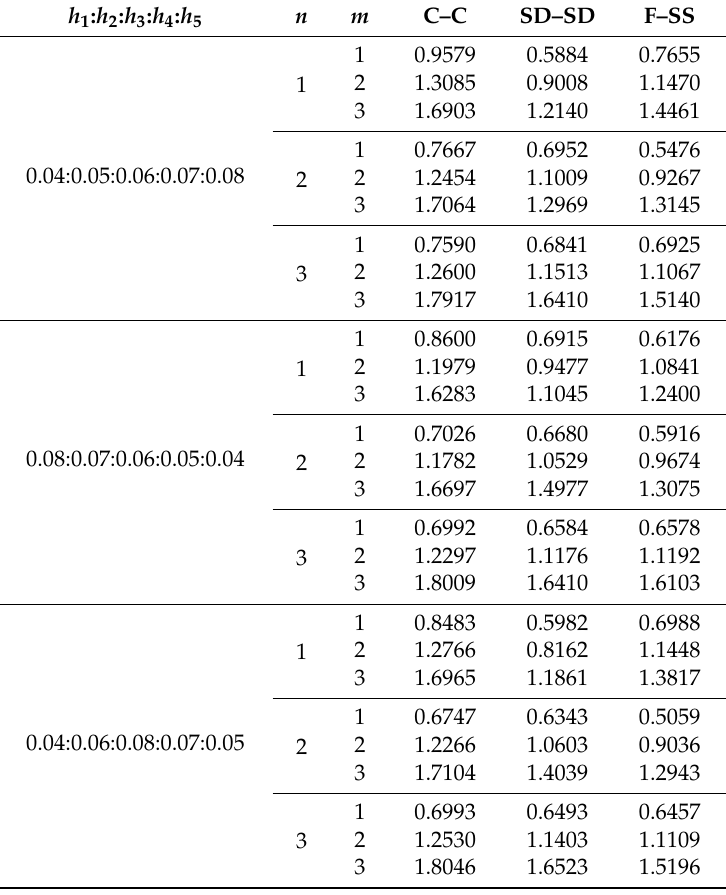
Table 7. Frequency parameters Ω for stepped FGM I ( a = 1; b = 0.5; c = 2; p = 2) shell with different thickness